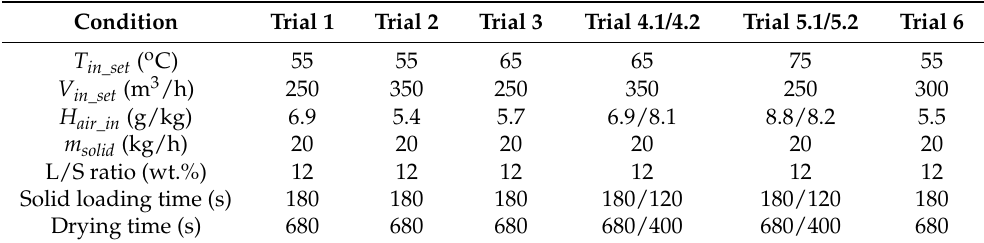
Table 2. Experimental conditions for the 6 trials.